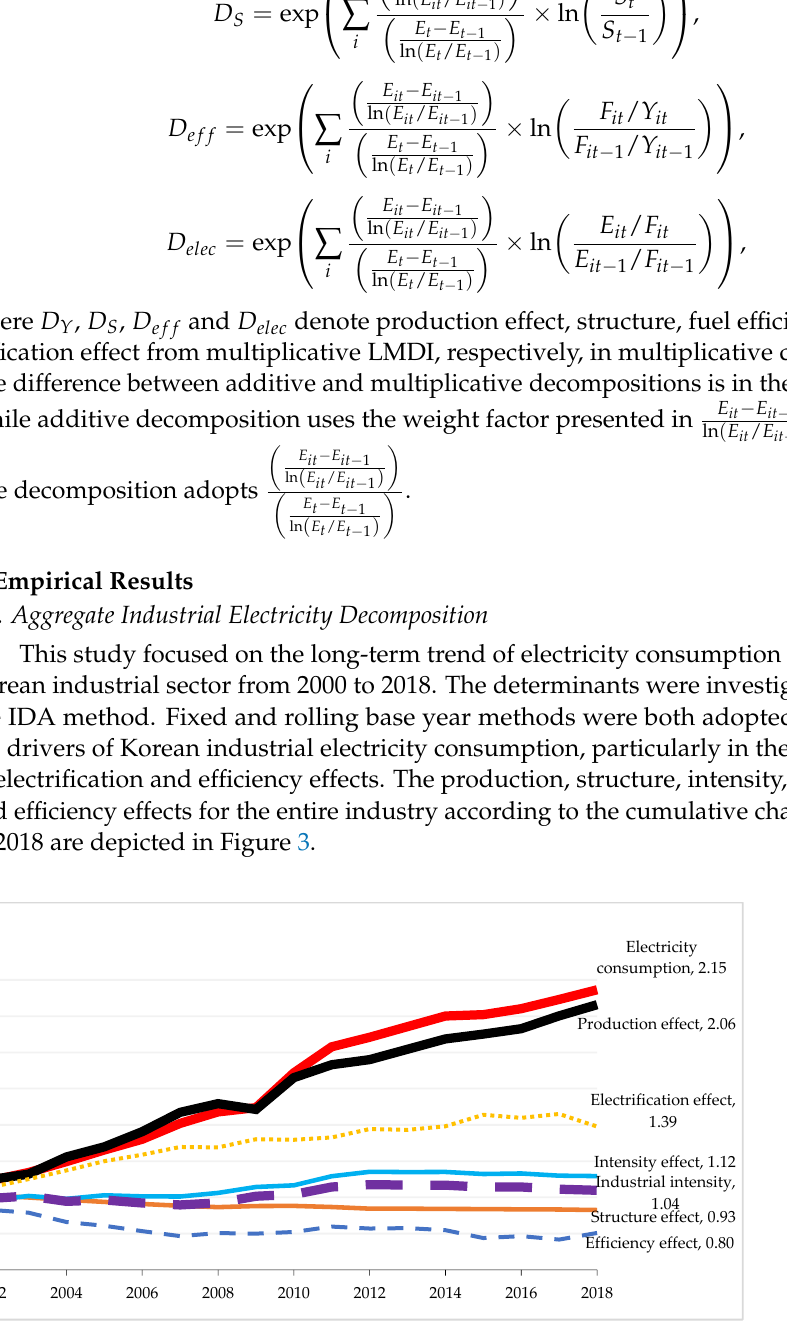
Figure 3. Aggregate electricity consumption LMDI results (fixed base year, multiplicative). A rolling base year approach was applied to the additive decomposition method for aggregate industrial electricity consumption (Table 2). In 2000 and 2018, the industrial electricity consumption rates were 132,260 GWh and 295,820 GWh, respectively. This demonstrates that industrial electricity consumption increased by 163,560 GWh, with an annual average growth rate of 4.1% from 2000 to 2018. The last row in Table 2 presents the fixed base year results for the target year 2018. The cumulation of the rolling base year approach shows the results of decomposition based on pairwise year changes.